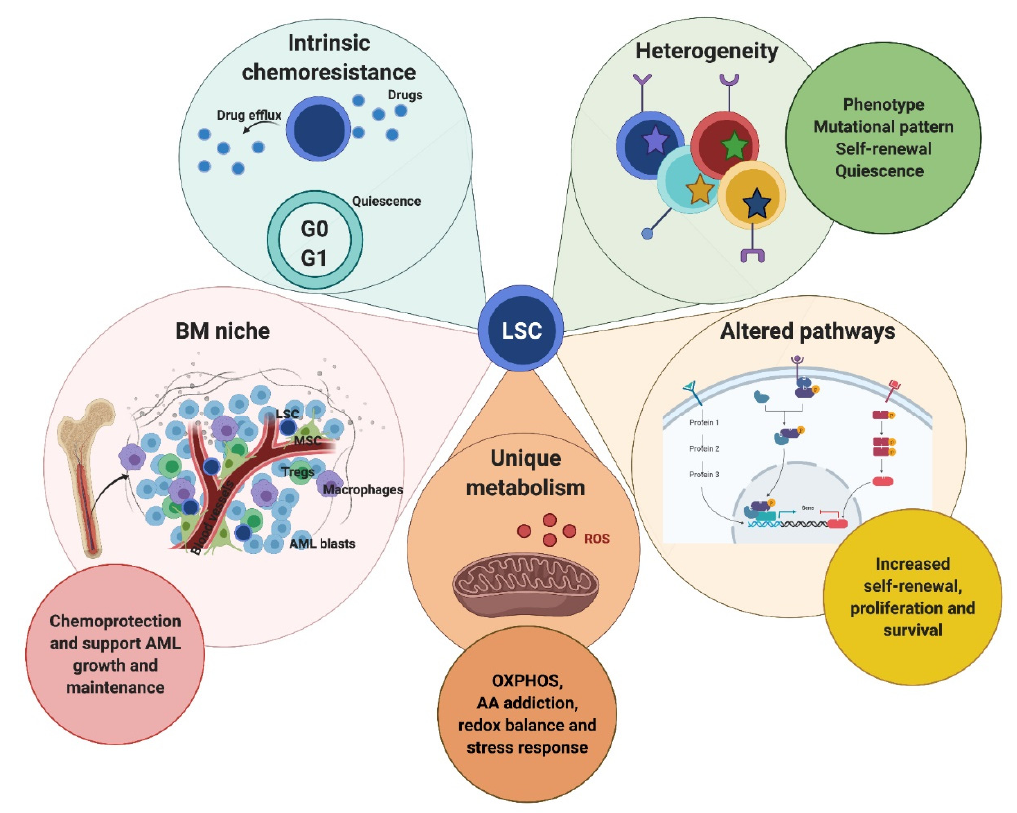
Figure 1. Summary of leukemic stem cell (LSC) distinctive features. LSC are characterized by phenotypic, mutational, self-renewal- and quiescence-related heterogeneity. This, in addition to intrinsic and extrinsic chemoresistance, could hamper acute myeloid leukemia (AML) treatment efficacy. The efflux pumps expressed on LSC surface and LSC quiescence determine their intrinsic drug resistance. Moreover, the AML-bone marrow (BM) niche represents a LSC cradle which supports AML cell expansion and survival providing chemoprotection. On the other hand, LSC exhibit unique metabolism and altered molecular pathways offering selective therapeutic targets. LSC, leukemic stem cells; BM, bone marrow; MSC, mesenchymal stromal cells; Tregs, regulatory T-cells; AML, acute myeloid leukemia; ROS, reactive oxygen species; OXPHOS, oxidative phosphorylation; AA, amino acids.